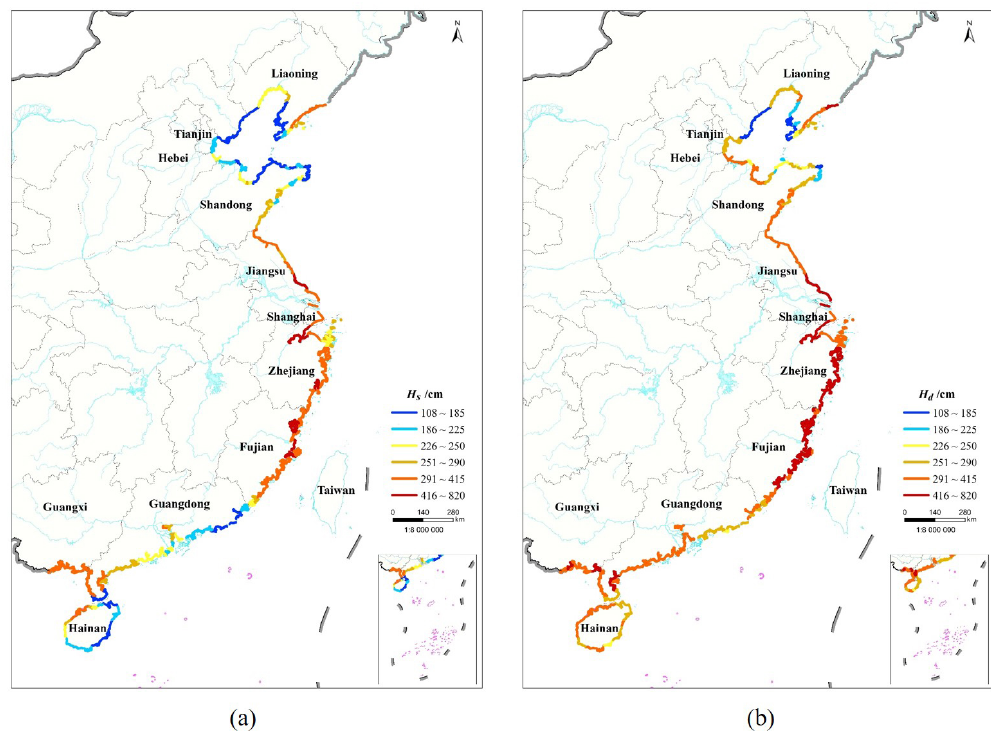
Figure 5. Spatial distribution map of H s and H d : (a) H s ; (b) H d .